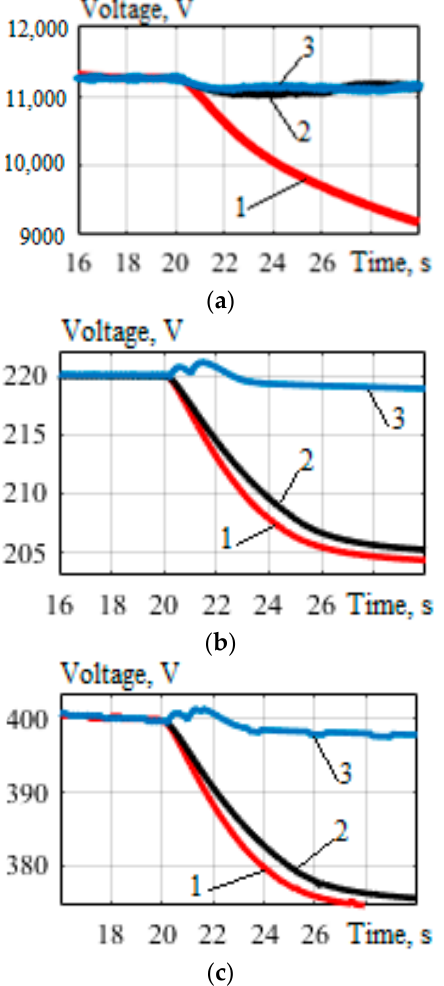
Figure 11. Time dependencies of voltages when the power supply system was switched off: ( a ) on the HV side of PR; ( b ) on the LV side of PR (DC grid); ( c ) on the LV side of PR downstream the inverter (in the AC grid);1—non-regulated PRs; 2—regulated PRs; 3—regulated PRs with additional ES units connected in the 220 V grid .